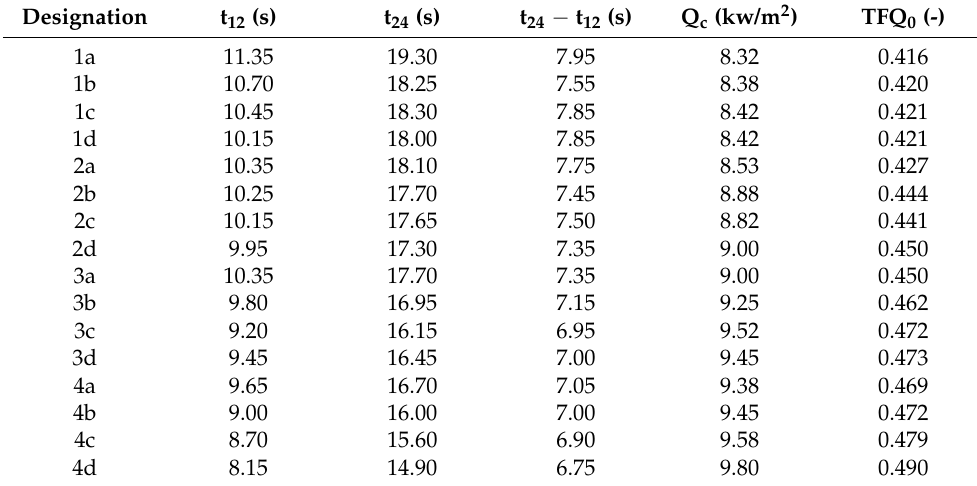
Table 4. Woven fabric resistance of radiant heat.